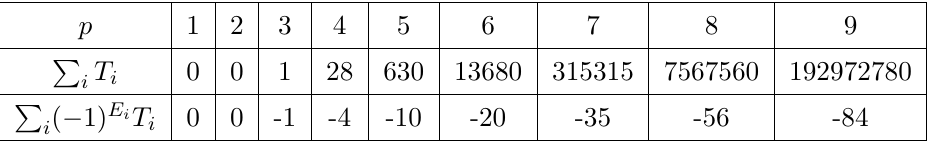
Table 1 . The sum (5.1) for even q and odd q up to 2 p =